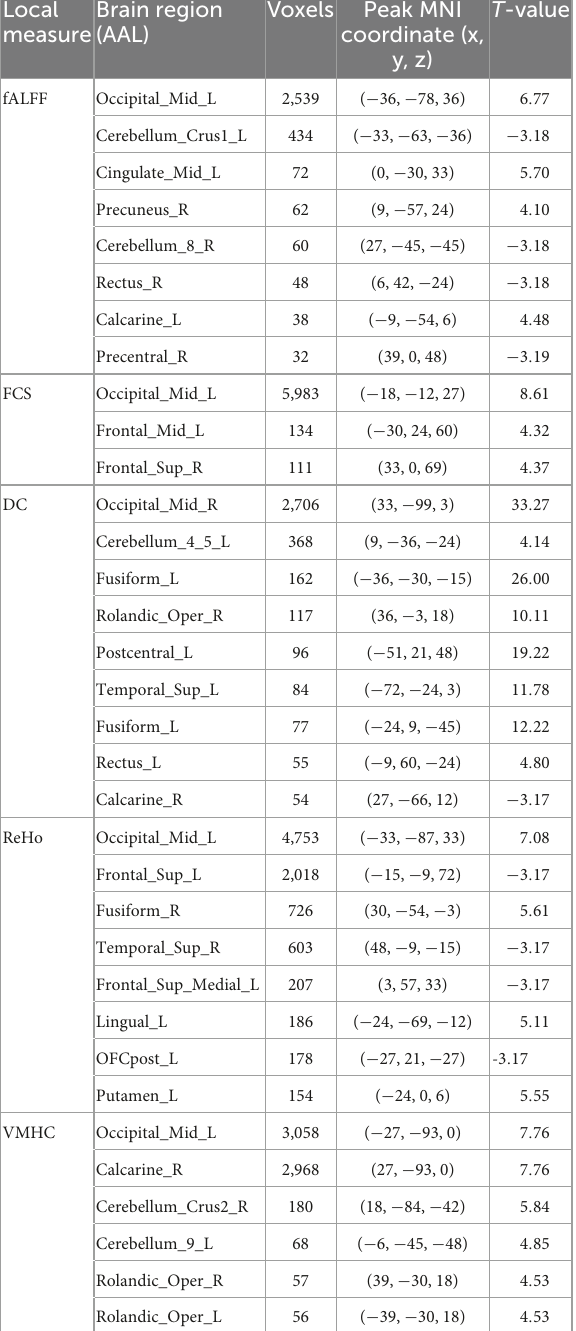
TABLE 3 Brain regions with significant local measure differences between the mTBI patients and